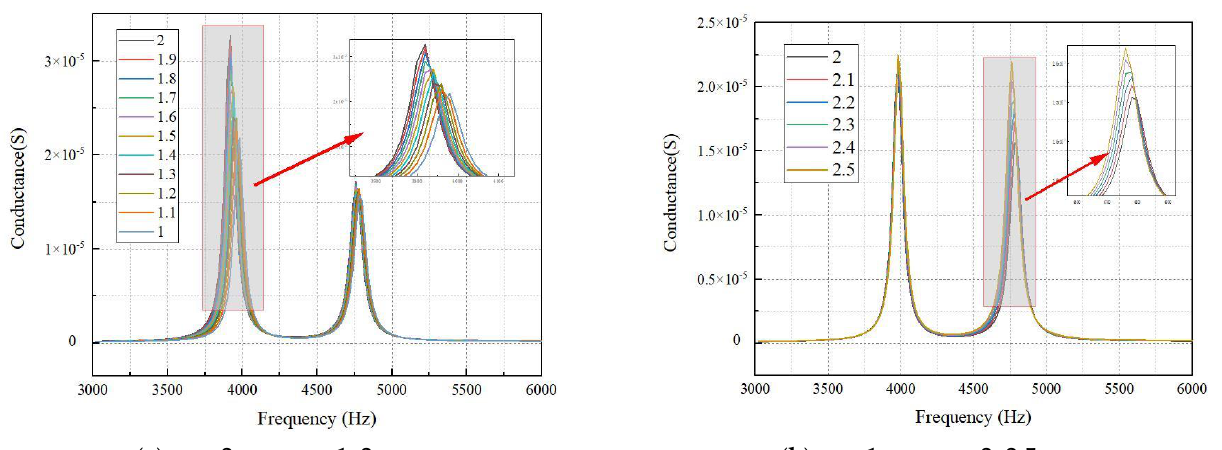
Figure 7. Conductance curves in different widths.